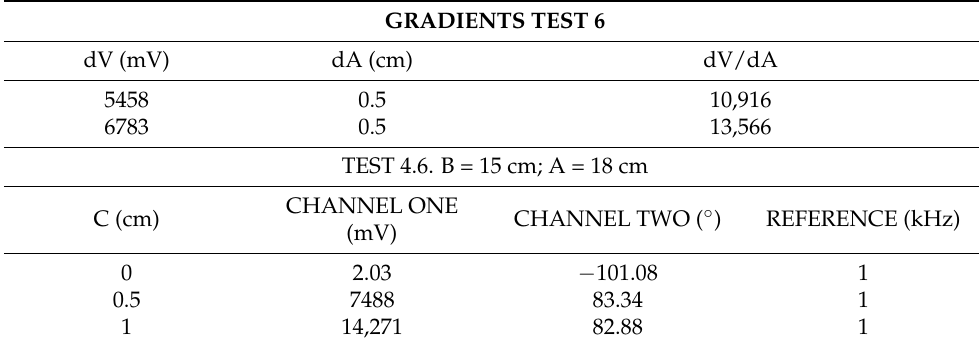
Table 4. Comparison of optimal data, Test 4.6.